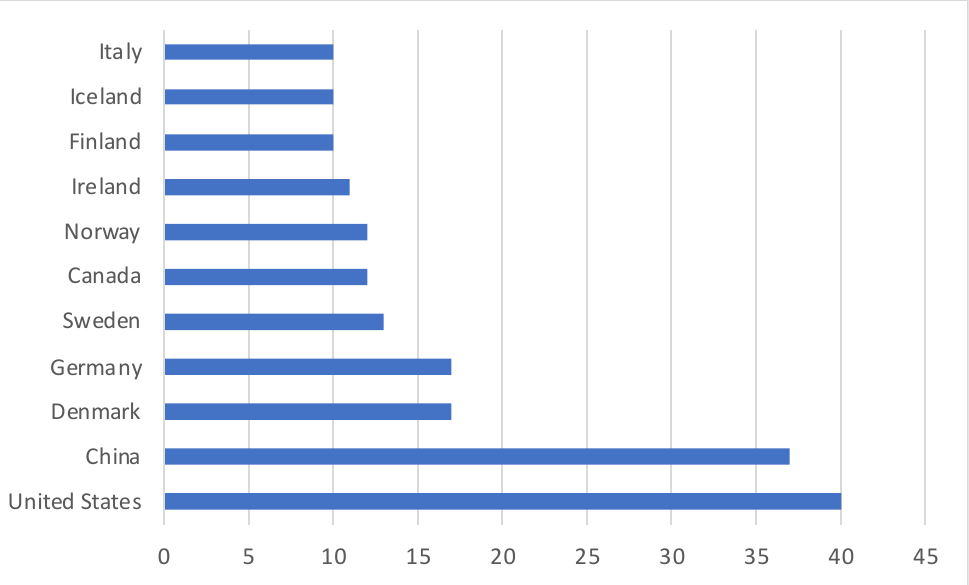
Figure 7. More studied countries *. * Only countries with 10 or more studies are included. Source: Authors’ own elaboration.